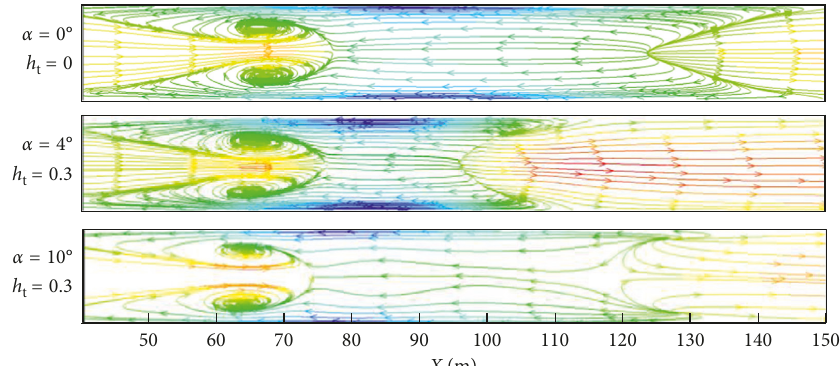
Figure 9: Local streamline distribution on X - Z plane for u � 1 m/s and Y �